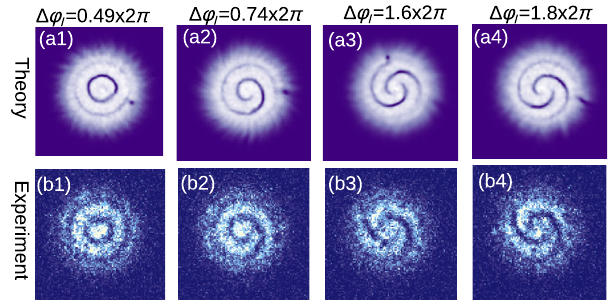
FIG. 8. Comparison between (a) numerical and (b) experimental BEC interferograms for different imprinted phases Δ ϕ (see I upper labels), corresponding to the imprinting times: (a1, b1) 64 μ s, (a2, b2) t 96 μ s, (a3, b3) t 204 μ s, and (a4, b4) t I ¼ I ¼ I ¼